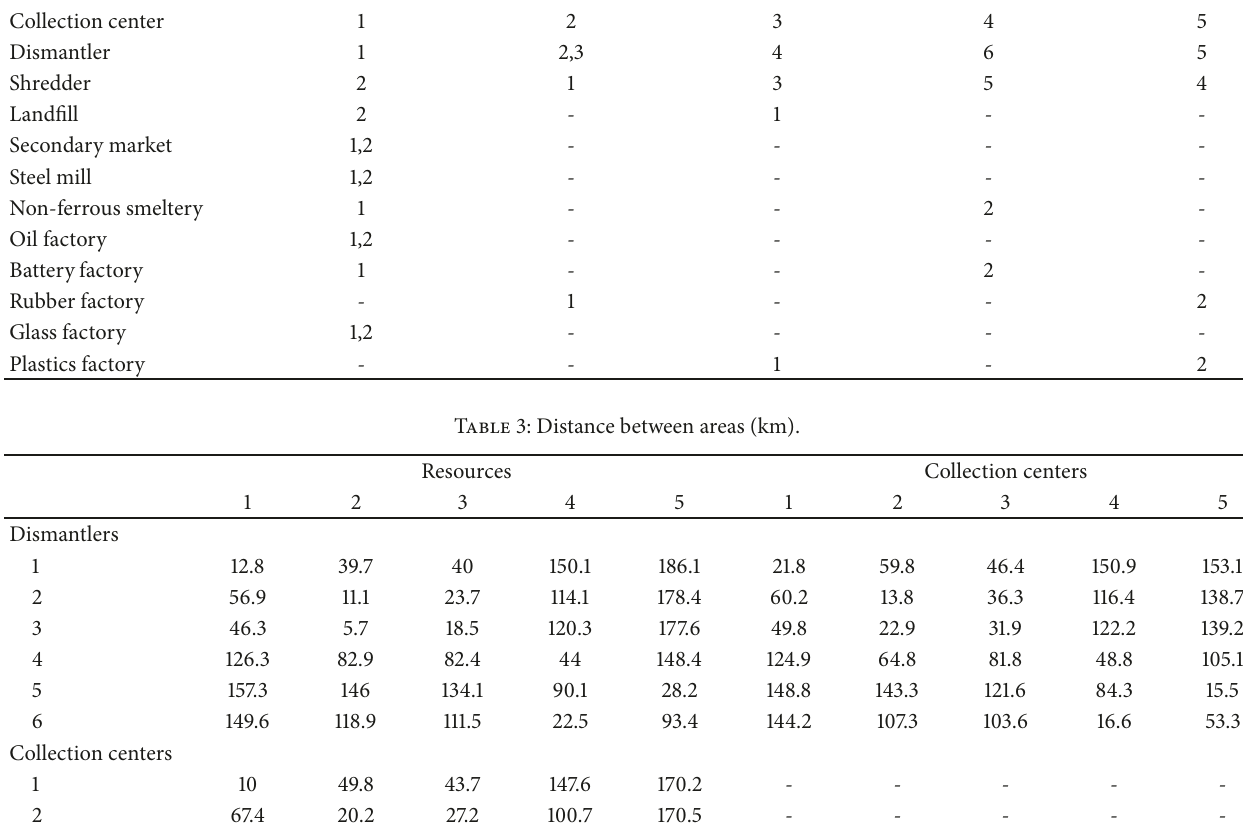
Table 2: Sites of all items.